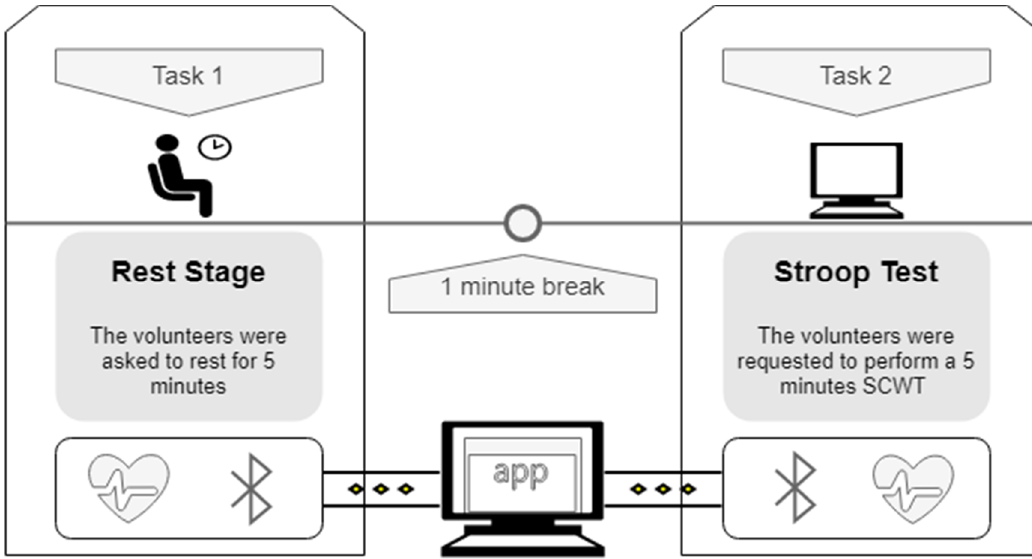
Figure 1. Representation of the experimental setup that was used for data acquisition. The experiment entailed two tasks with a duration of five minutes, separated by a one-minute break. Data was acquired and transmitted to a computer via Bluetooth low energy (BLE) using the Polar H10 and James One heart rate sensors, simultaneously.